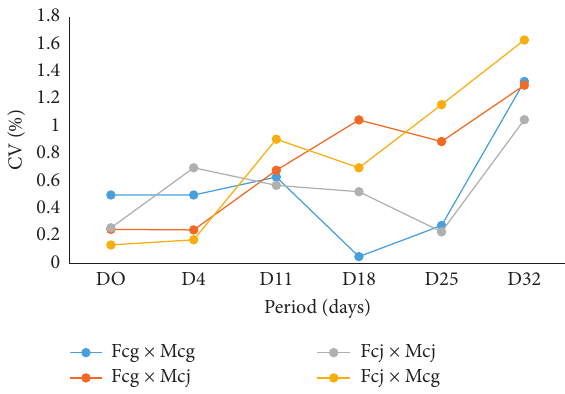
Figure 6: Coefficient of variation of size according to genetic type in reciprocal hybridizations of Clarias gariepinus × Clarias jaensis in controlled conditions. The female was named first.